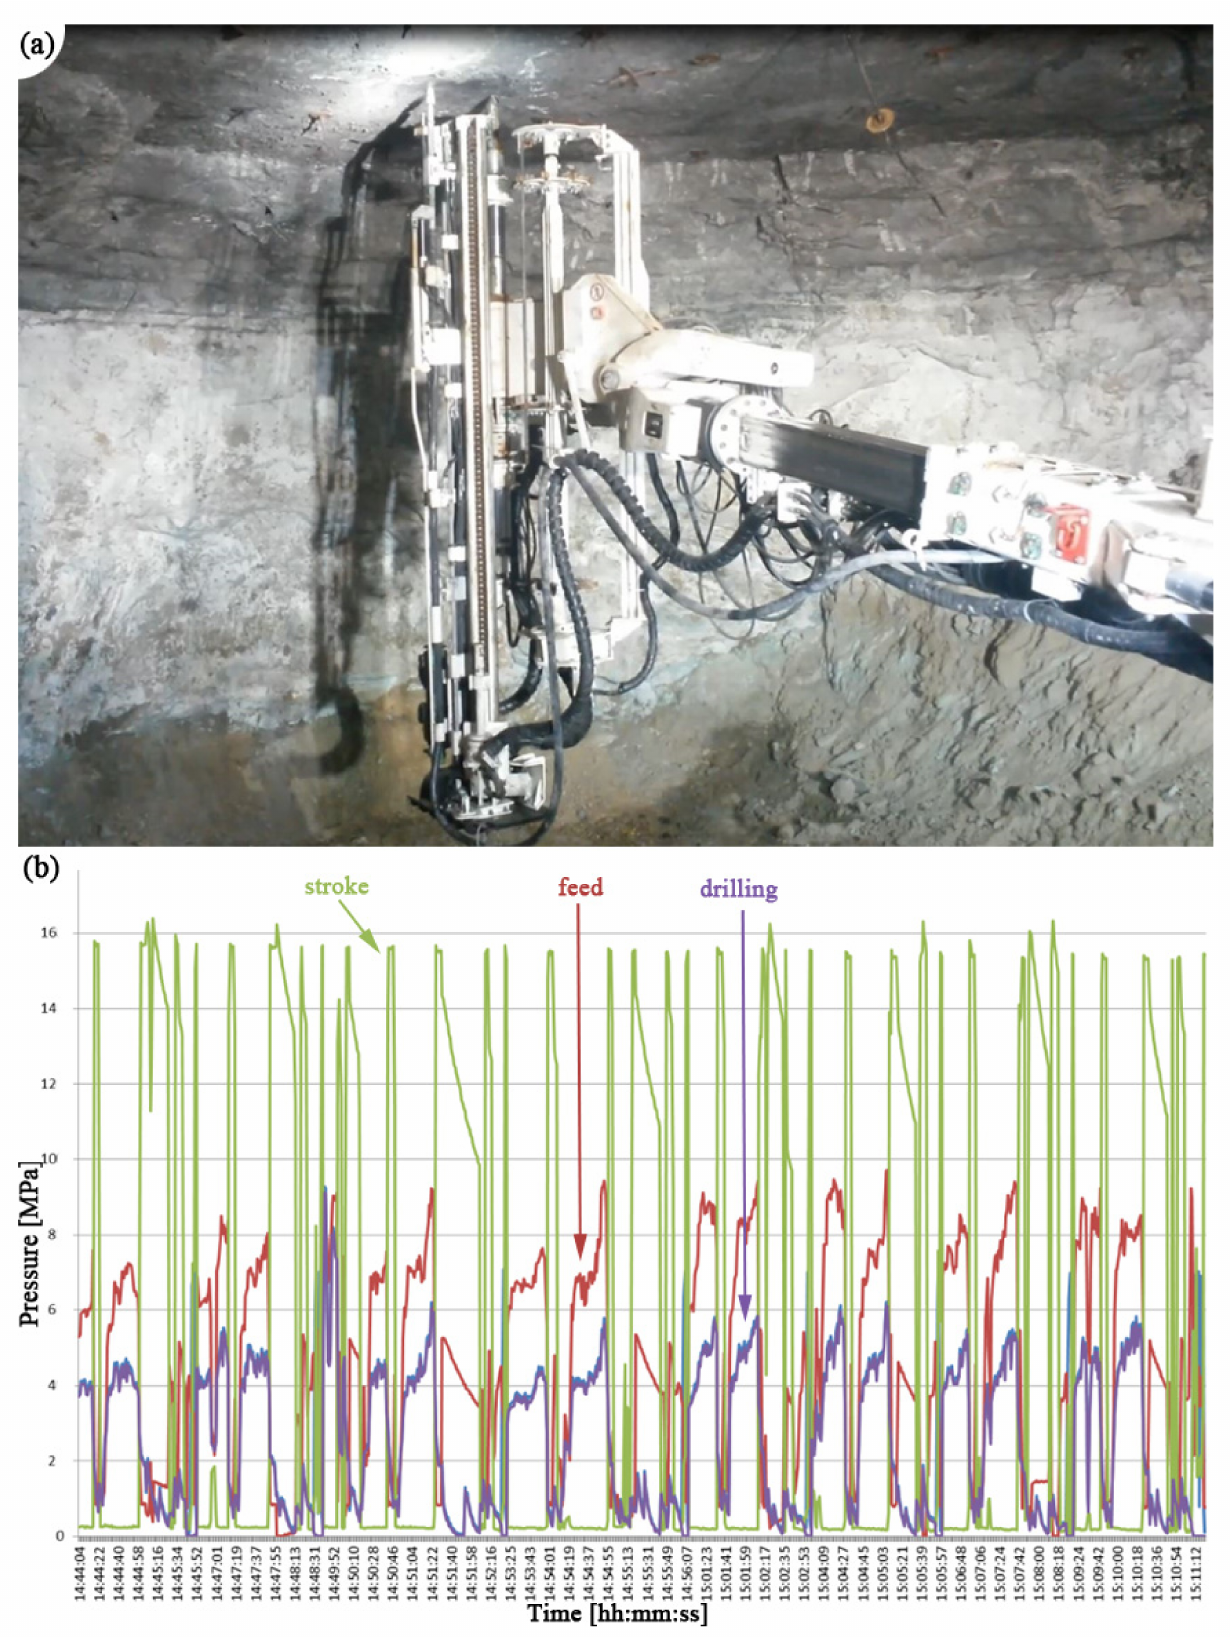
Figure 2. Underground tests in the KGHM mine: ( a ) Roof Master RM 1.8 diesel bolting rig, ( b ) recorded pressure courses in the turret hydraulic